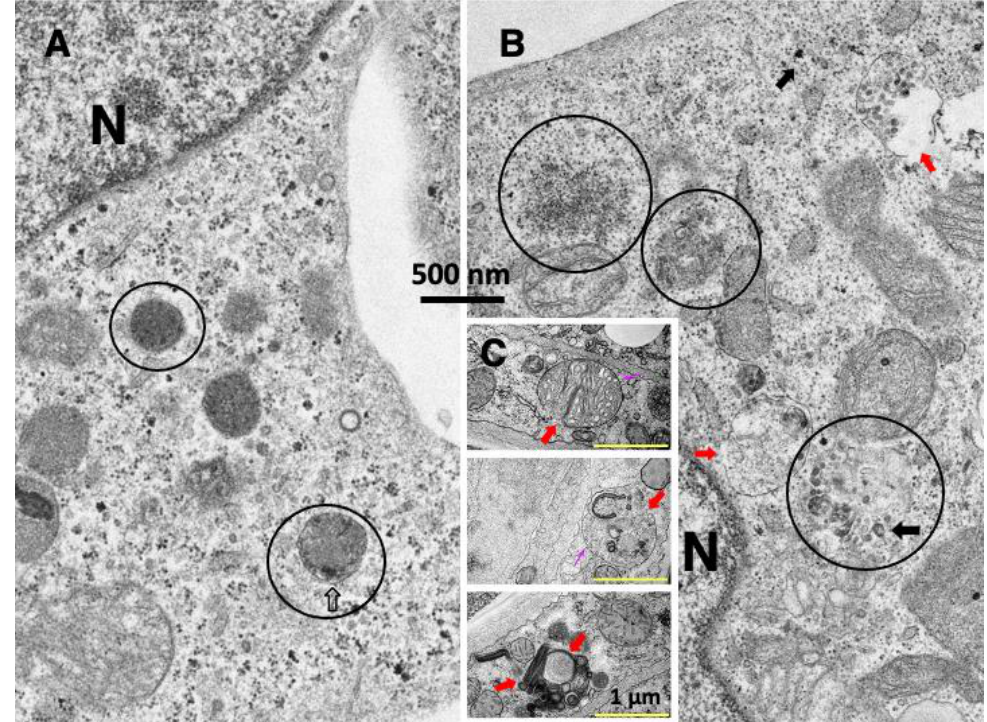
Figure 2. Electron microphotographs of hepatocellular carcinoma cell lines after hydroxynonenal treatment. Although lysosomes of the control cells ( A ) are bound by the distinct limiting membrane (( A ) circles, open arrow), those of the carcinoma cells after hydroxynonenal treatment show partial (( B ) red arrows) or total (( B ) circles) disruptions of the lysosomal-limiting membrane with the resultant release of the content (( B ) black arrows). Loss of scav- 3 , the Caenorhabditis elegans homologue of human LIMP-2 as a key regulator of lysosome integrity, caused similar rupture of the lysosomal-limiting membrane (( C ) red arrows). Pink arrows show the intact portion of the limiting membrane, whereas red arrows show ruptured sites of membrane at lysosomes N; nucleus. (( C ) adapted from [38]).